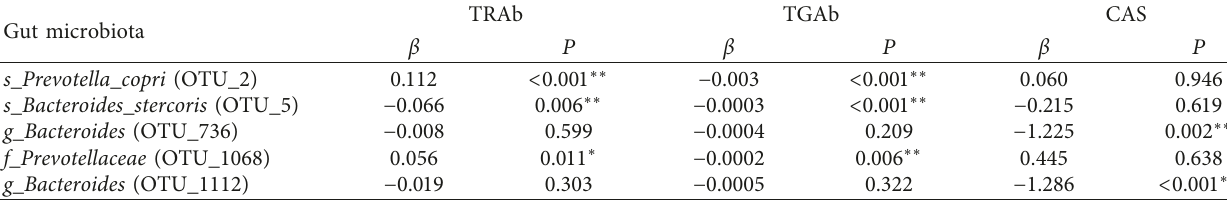
Table 3: Associations between gut microbiota and GO-related traits.